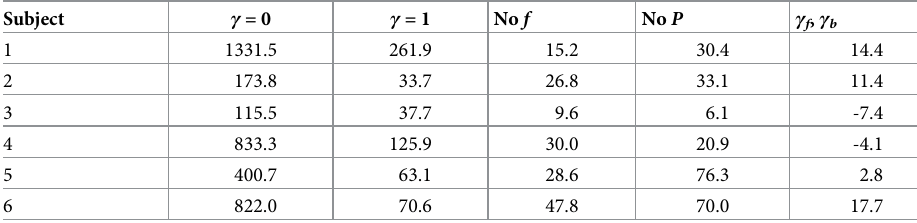
Table 1. Relative increase in BIC score for alternative